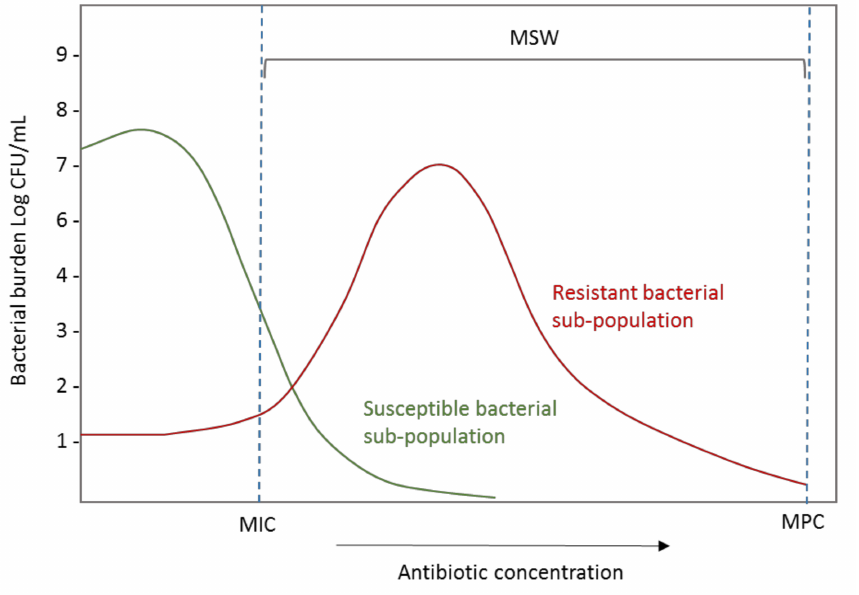
Figure 8. Effect of exposure to the increasing antibiotic concentration on the burden of resistant and susceptible bacterial populations. CFU: Colony-forming units; MIC: Minimum inhibitory concentration; MPC: Mutant prevention concentration; MSW: Mutation selection